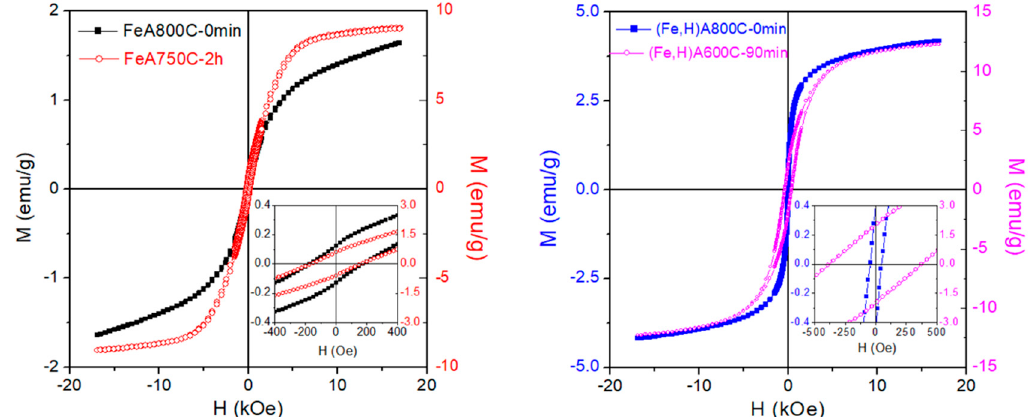
Figure 8. Room temperature hysteresis loops of four Fe NCs obtained from an A-type zeolite under different thermal treatments and exchange processes.